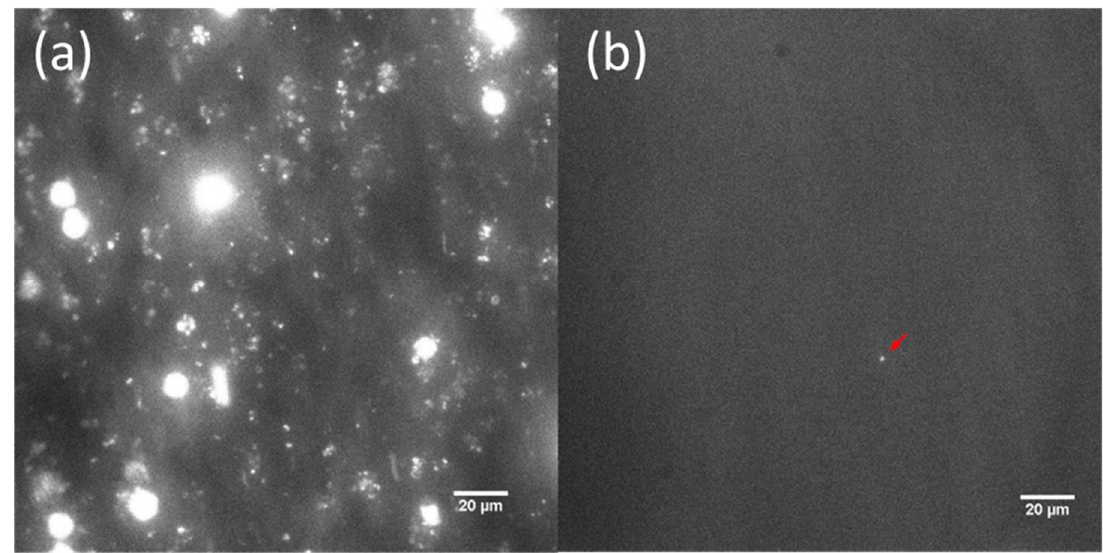
Figure 4. Representative images after 20 min of blood perfusion at 100 s − 1 shear rate showing platelet aggregation on bare ( a ) and MEG-OH-modified 316L stainless steel ( b ).